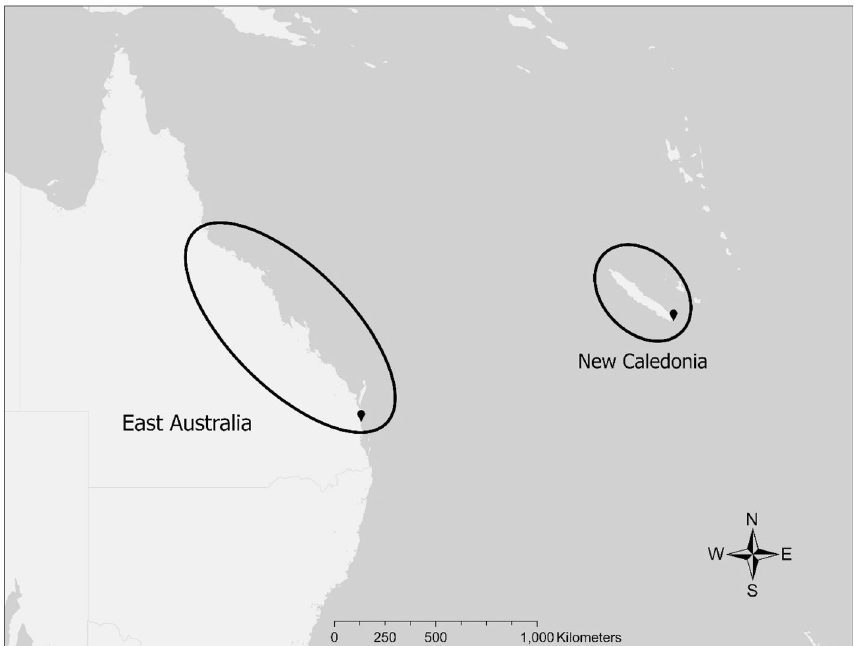
Figure 3. The location of each population, east Australia and New Caledonia, in relation to one another as well as deployment sites in black for data collection in each